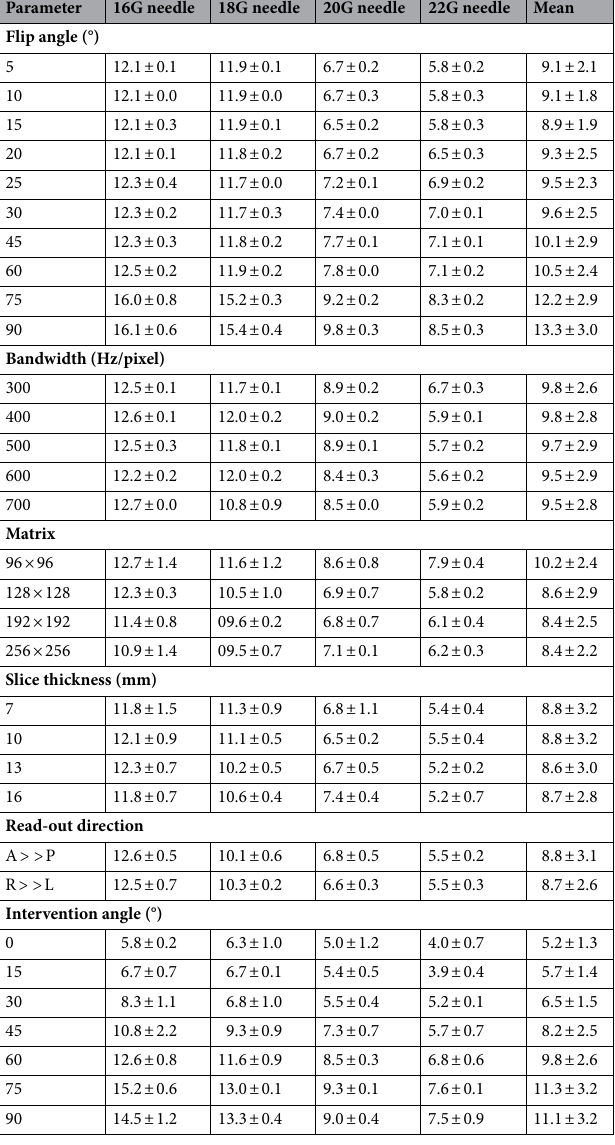
Table 1. Artifact diameter measurements. Measured artifact diameters (in mm) at various sequence parameters, averaged over both readers. Values presented as means ± SD. SD standard